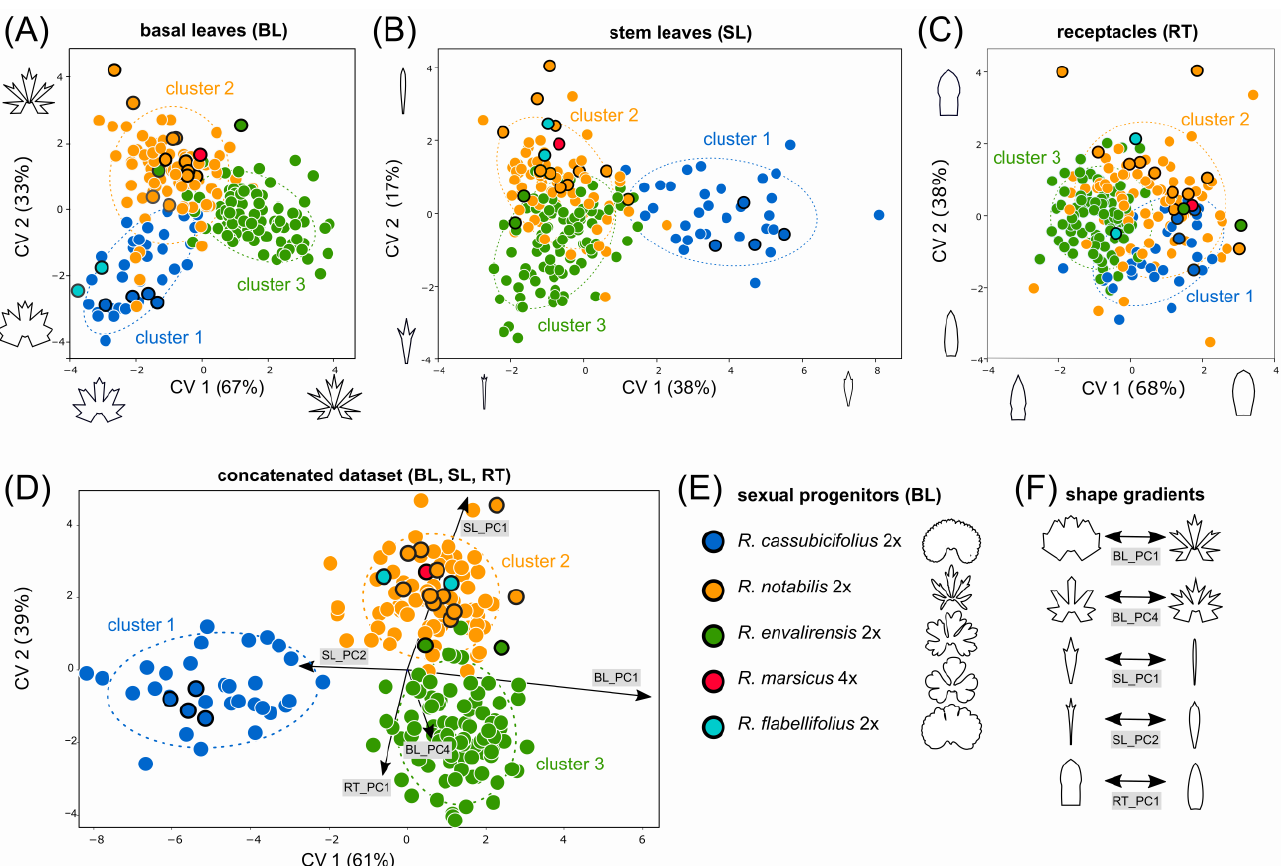
BL (cluster 1—cluster 2 and 3), and between narrowly, three-lobed BL with roundish segments and broadly, three-lobed BL with acuminate segments (cluster 2—cluster 3), respectively; the first two SL principal components (SL_PC1, SL_PC2), describing shape 3—cluster 2), and between linear SL with sinuses and oval segments SL (cluster 2 and 3—cluster 1), respectively; and the first RT principal component (RT_PC1), describing shape variation between broad and long androclinium and oval and short gynoclinium RT on the one side and short and narrow androclinium and high gynoclinium RT on the other side (cluster 2—cluster 1 and 3).